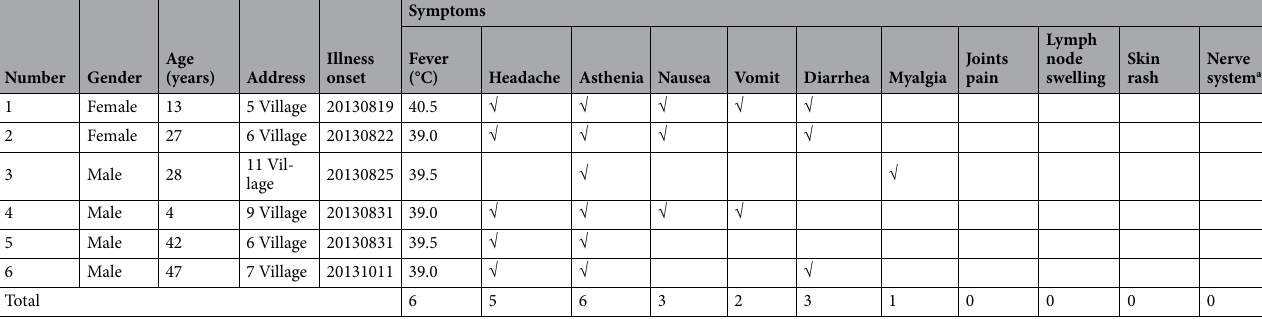
Table 3. Information of 6 WNF cases in Kashgar Region, 2013. a Neurological manifestations include: